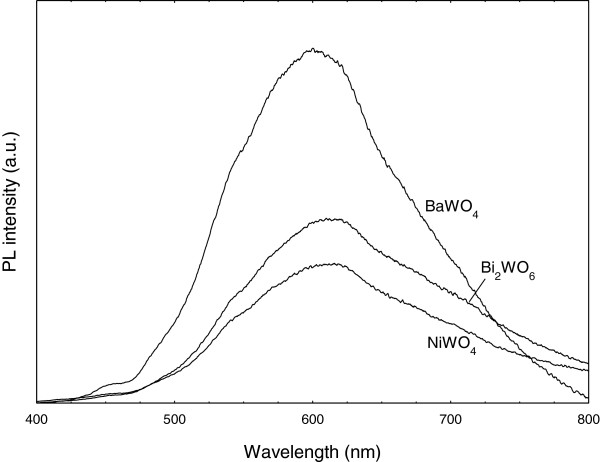
Photoluminescence spectra of BaWO4, NiWO4 and Bi2WO6 samples.